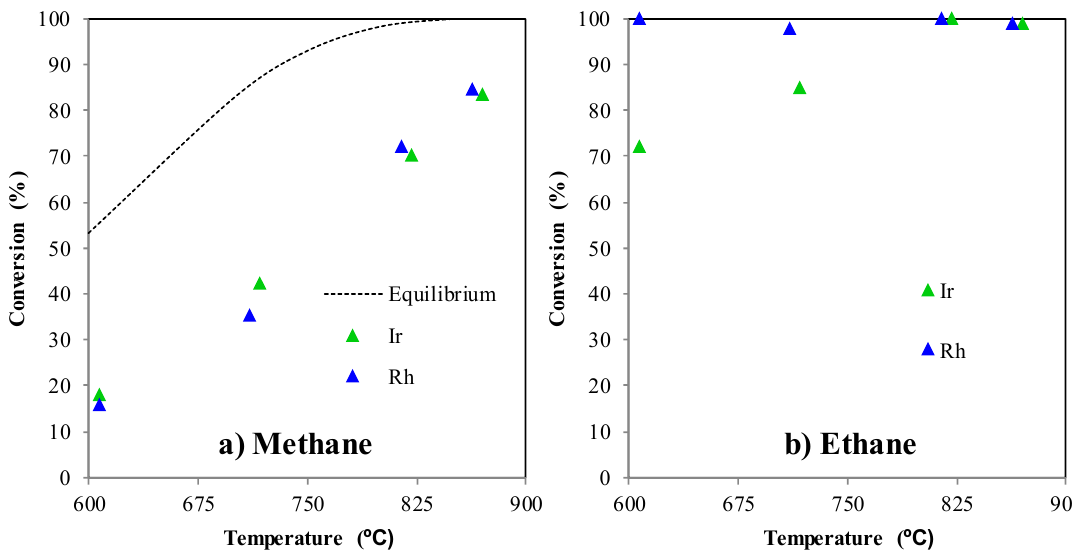
Figure 3. Comparison of ( a ) methane conversion and ( b ) ethane conversion for the Rh and Ir catalysts when steam reforming using natural gas simulant feedstock (S/C = 1.5 mol, τ = 4.5 ms).